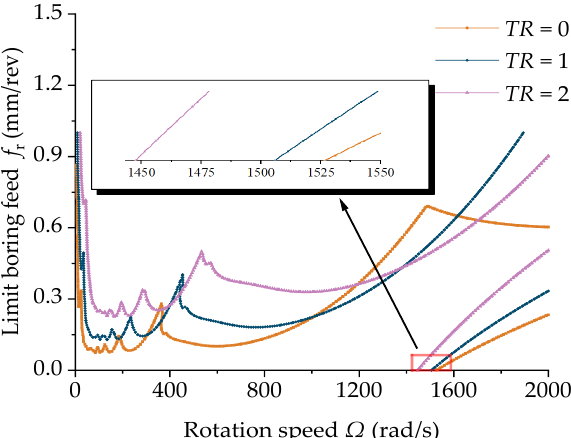
Figure 16. Effect of the taper ratio on the stability of the boring bar ( ψ = 1 and L = 2 m).